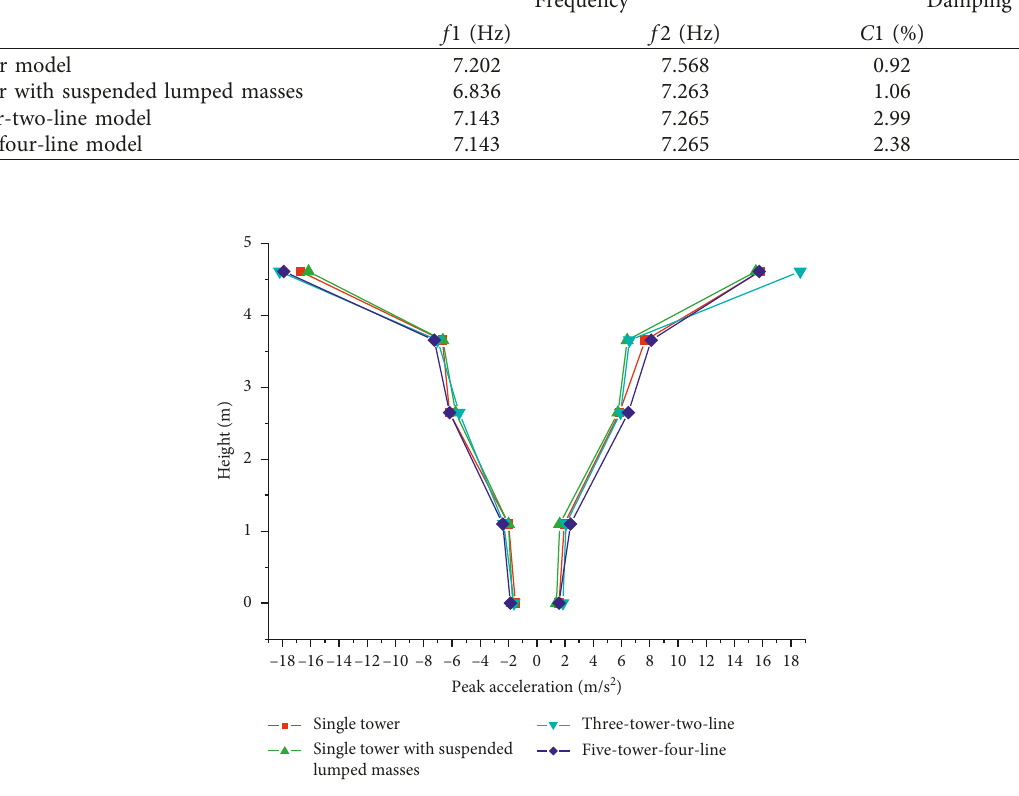
Figure 22: Longitudinal peak acceleration responses of the middle tower of the four models under a 0.21g artificial